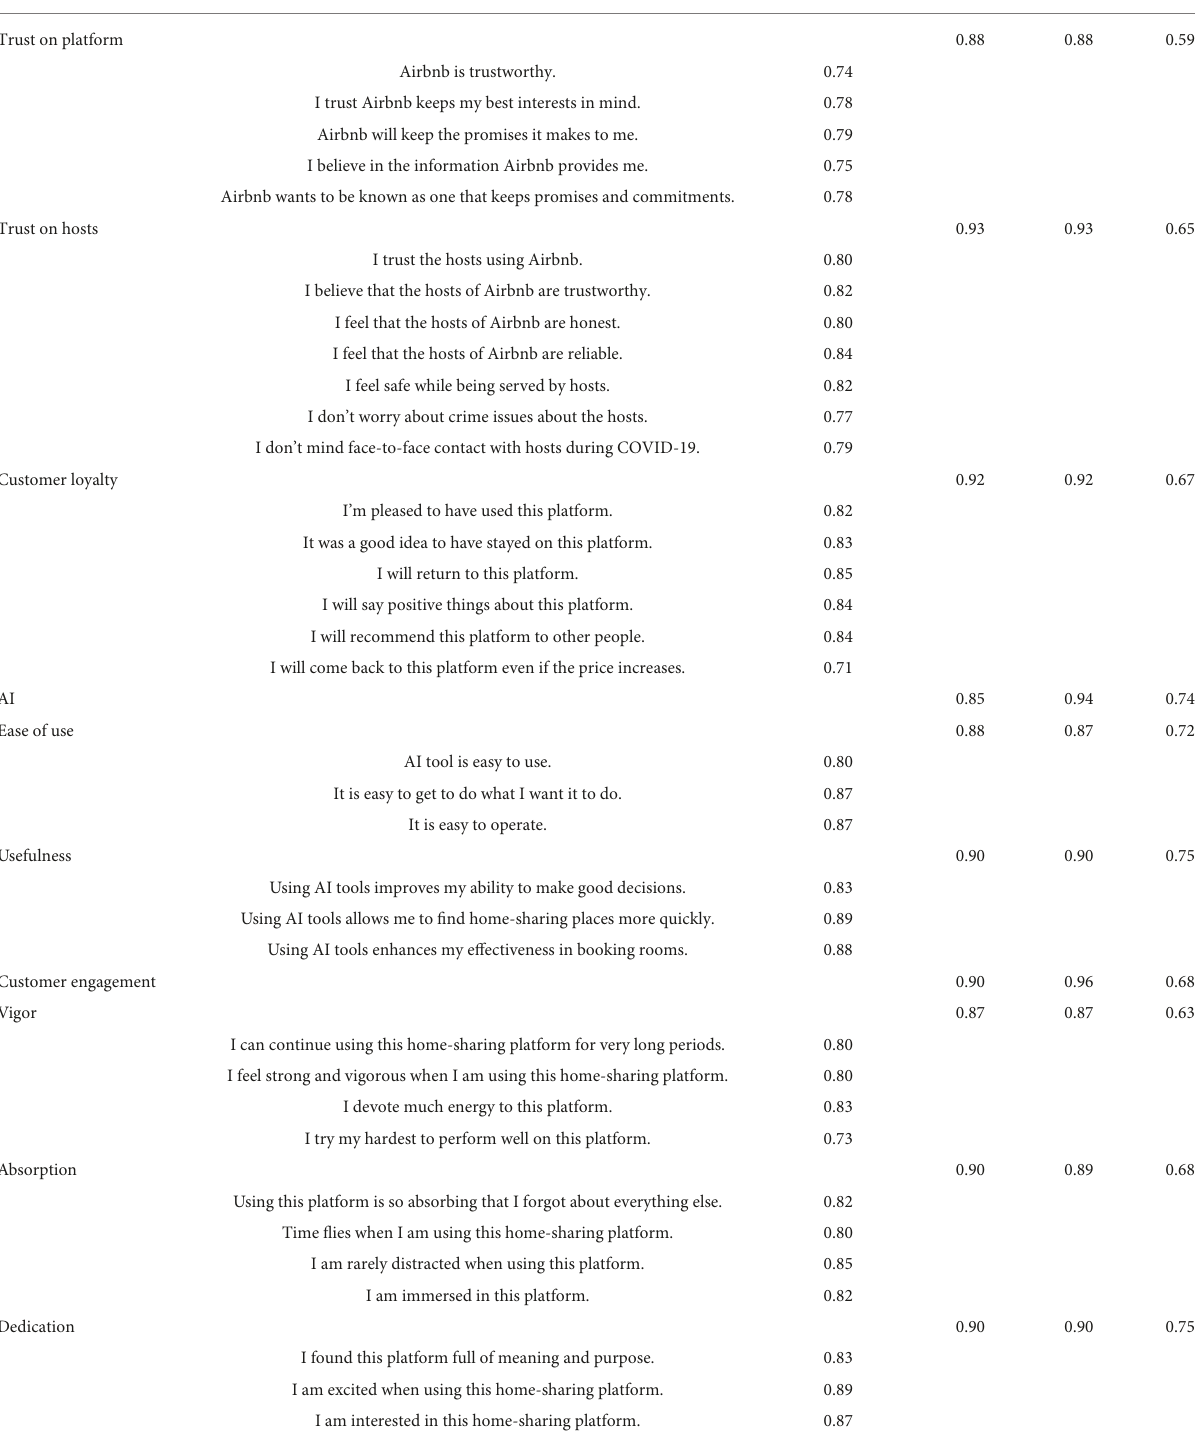
TABLE 4 Confirmatory factor analysis results.